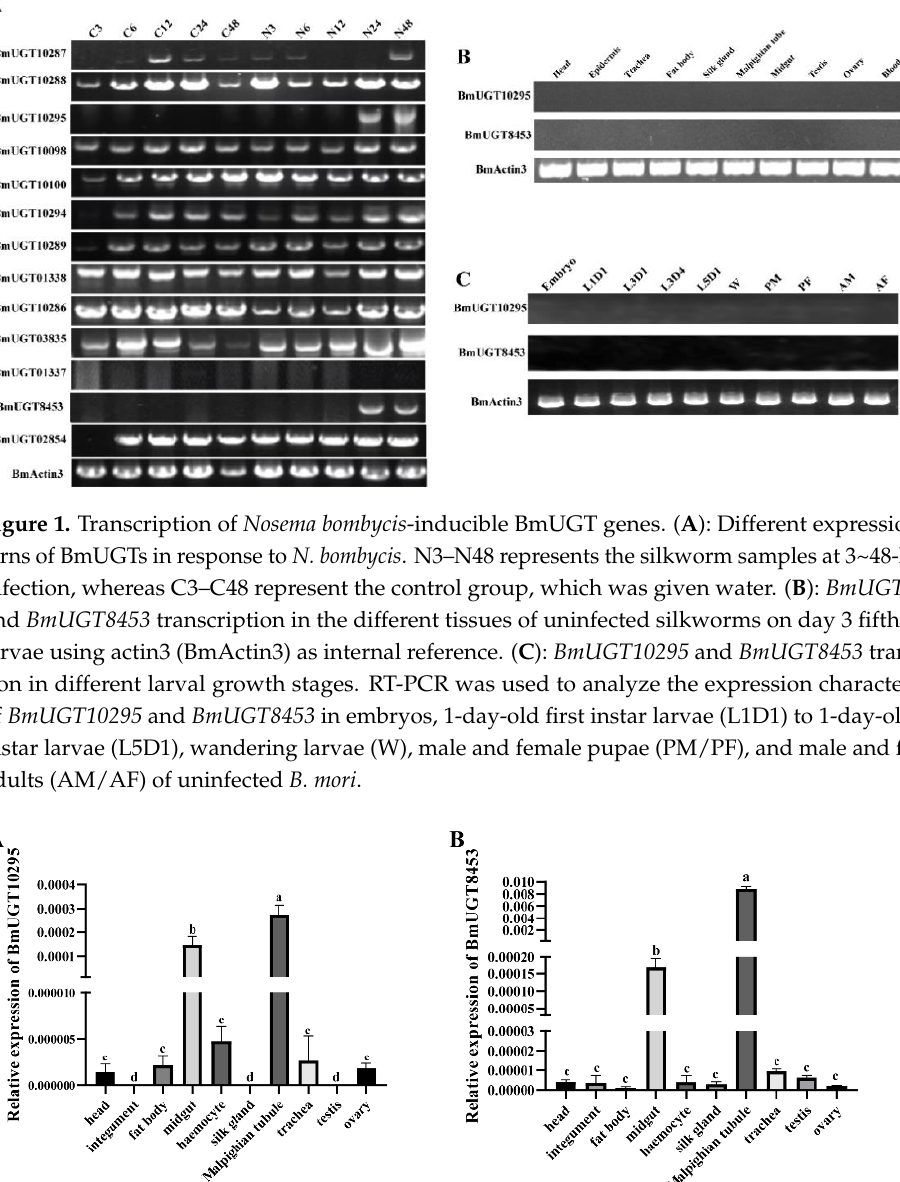
Figure 1. Transcription of Nosema bombycis -inducible BmUGT genes. ( A ): Different expression pat-